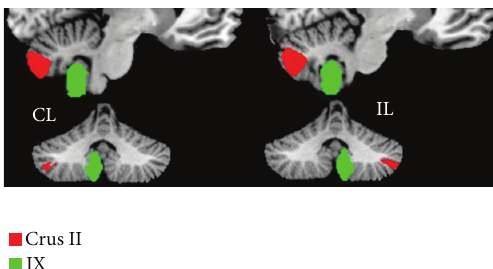
Figure 2: The bilateral seed regions of the cerebellar subregions of crura II and IX extracted from the probabilistic cerebellar atlas with a threshold of 50% minimum